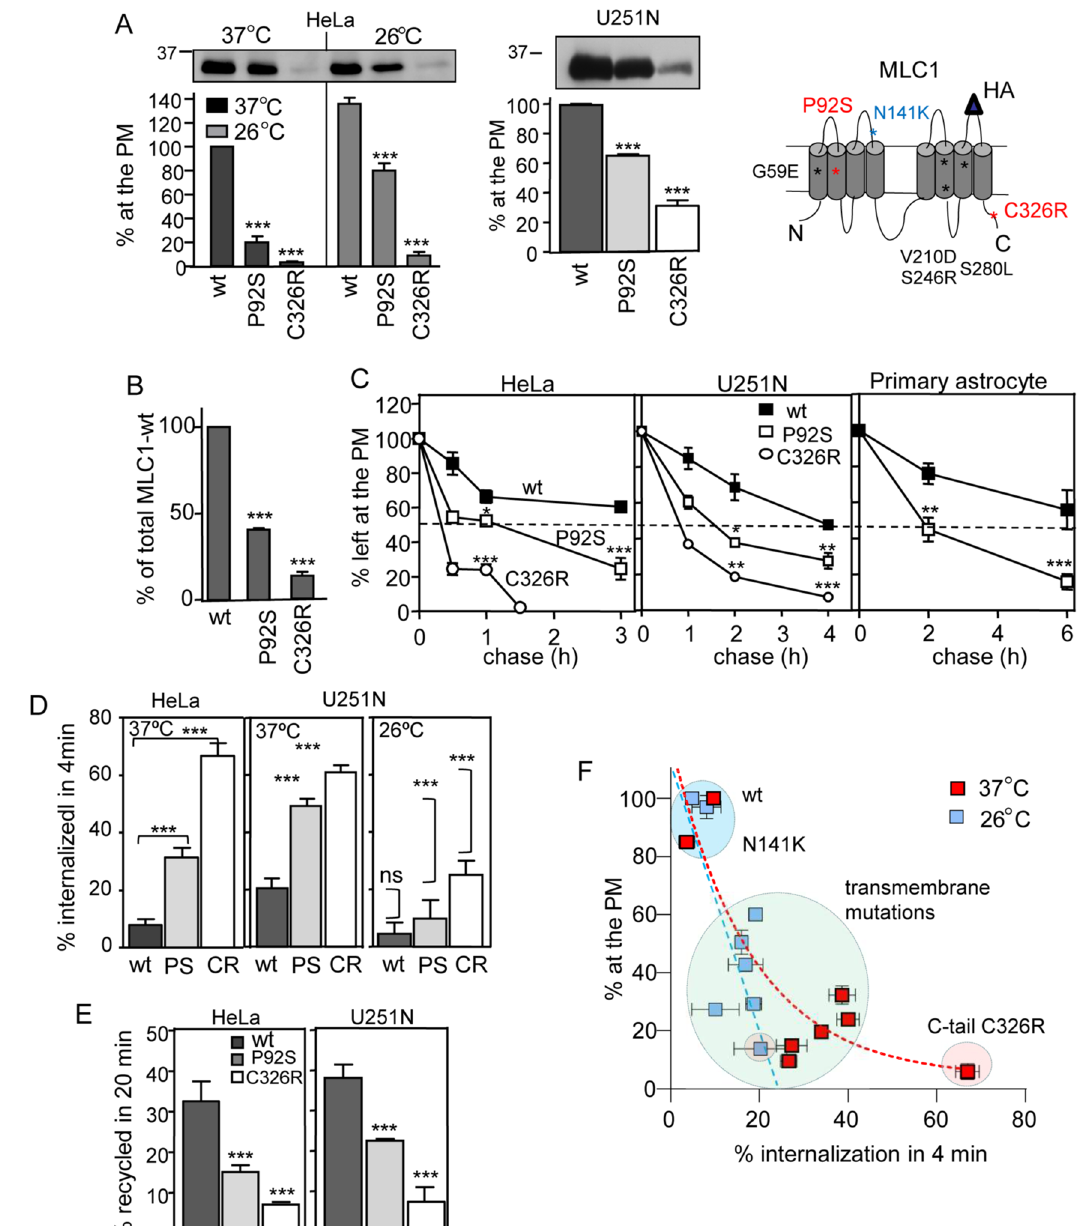
Figure 1. Disease mutations destabilize the regulatory protein MLC1 in multiple cell types. ( A , B ) The correlation between the PM density and cellular total protein expression of MLC1 variants (wt, P92S, C326R) was measured at 37 °C and upon temperature rescue (26 °C, 24 h) in HeLa cells by cs-ELISA and Western blot analysis with densitometry. ( C ) The PM turnover of MLC1 variants was monitored in the primary astrocytes, HeLa, and astrocytic U251N cells using cs-ELISA. ( D ) Internalization rates of the MLC1 variants (wt, P92S, C326R) were determined using cs-ELISA. Internalization was initiated at 37 °C for 4 min after anti-HA binding at 4 °C in HeLa cells maintained at 37 °C or after following low-temperature rescue (26 °C, 24 h). Statistical significance in the internalization rate of non-rescued (37 °C) and low-temperature rescued (26 °C) MLC1 variants are indicated on the right panel (U251N, 26 °C). ( E ) The endosomal recycling rates of MLC1 variants [wt, P92S (PS), C326R (CR)] were measured in HeLa and astrocytic U251N cells as described in “Materials and methods”. ( F ) Correlation between internalization rates (%/4 min) and relative cell surface densities (% of the wt) of eight MLC1 variants in HeLa cells at 37 °C (red squares) or after temperature folding rescue at 26 °C (24 h, blue squares). Data are from the Fig. S1B,C. Means ± SEM, n ≥ 3, *p < 0.05, **p < 0.01, ***p <